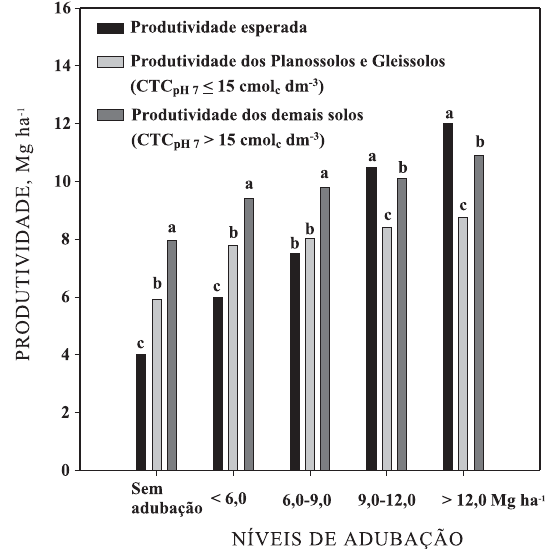
Figura 2. Produtividade de grãos de arroz irrigado em função da adubação para diferentes